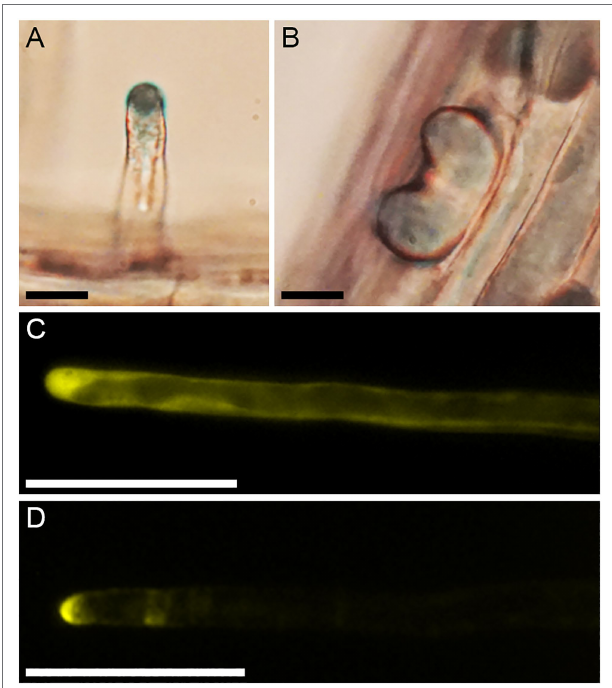
FIGURE 6 | ROS and SCN1 localization in root hairs. NBT staining of (A) wild type A. alpina and (B) Aascn1-1 . Localization of the SCN1 protein from (C) A. alpina and (D) Arabidopsis thaliana in A. thaliana Col-0 background. Scale bar: 10 μ m (A, B) and 50 μ m (C, D).